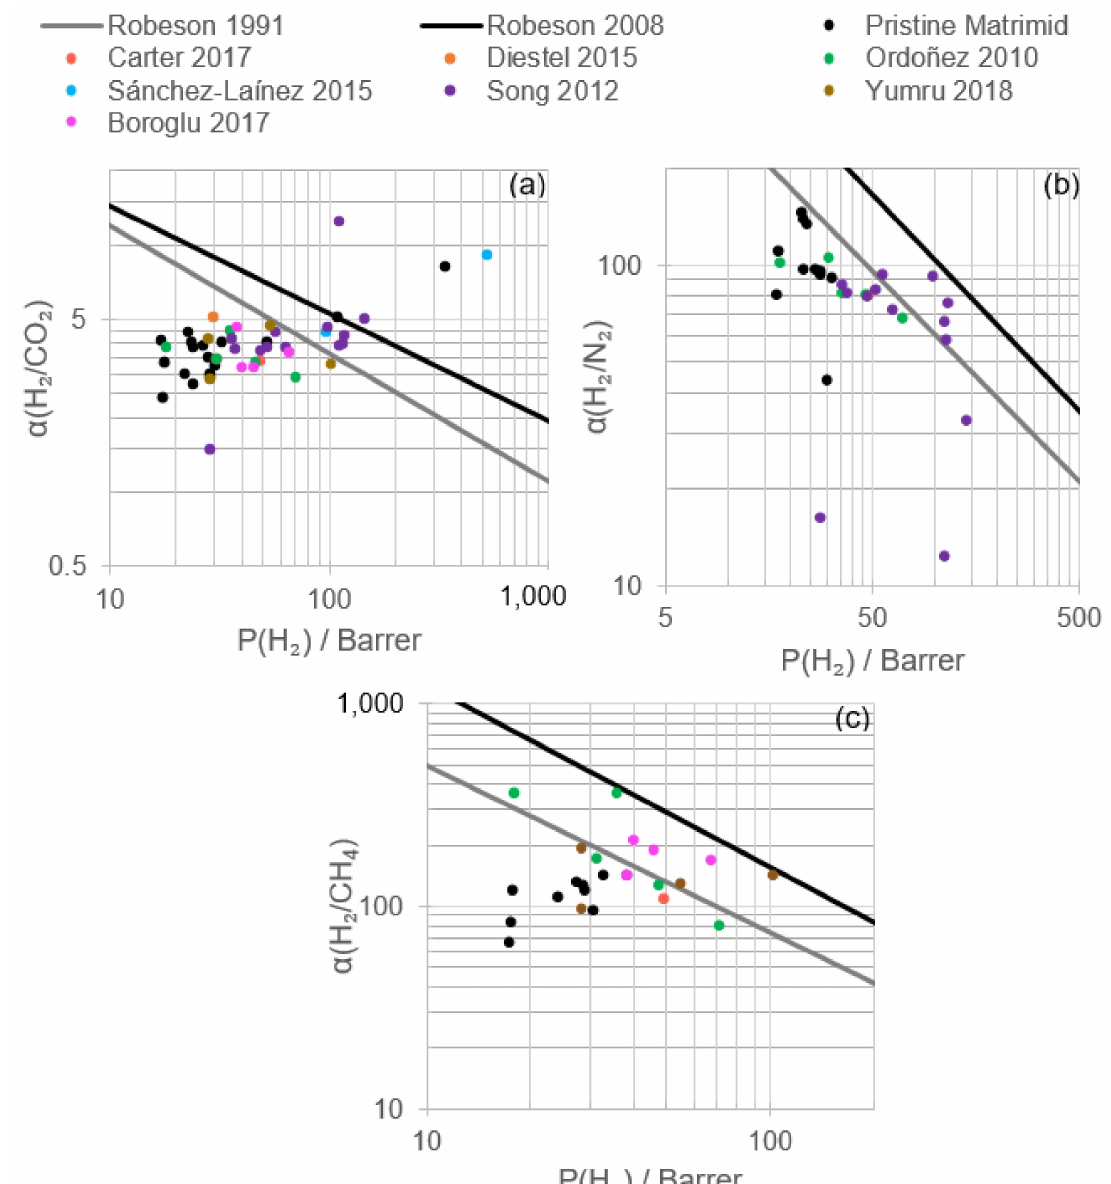
Figure 6. Robeson plot for ( a ) H 2 /CO 2 , ( b ) H 2 /N 2 and ( c ) H 2 /CH 4 single gas permeation tests through Matrimid ® /ZIF mixed matrix membranes (MMMs). Pristine Matrimid refers to the total of the results included in Figure 4. Reference correspondence is found in Table